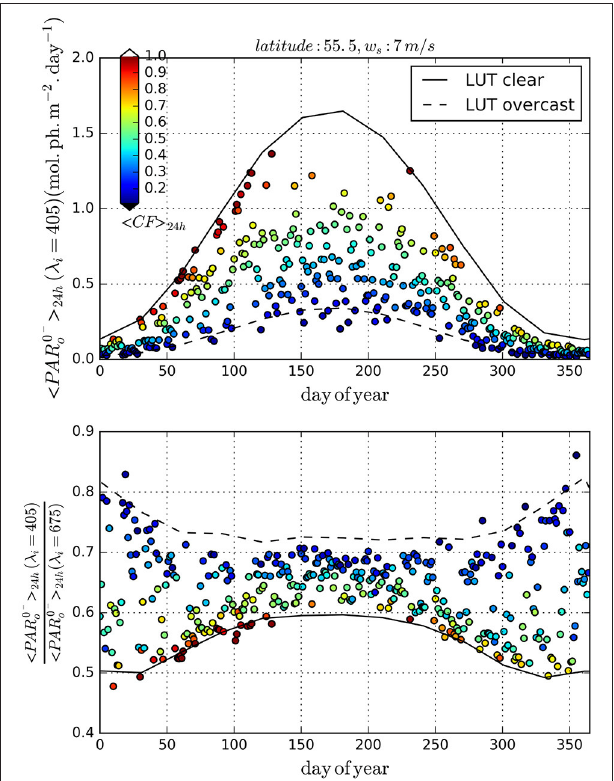
FIGURE 13 | (Top) Scalar PAR below the surface integrated in a narrow spectral band (400–410nm) for all the days of 2011 (dots), for a particular latitude and wind speed, as well as predicted values for clear sky (solid line) and totally overcast situations (dashed lines). (Bottom) Same as top but normalized by the band integrated scalar PAR below the surface between 670 and 680nm. The color of the dots is a function of the cloud